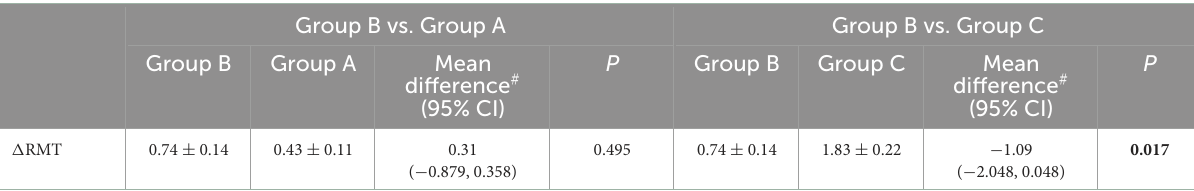
TABLE 9 Comparison of 1 RMT between the soft machine glove group and the conventional therapy and repetitive transcranial magnetic stimulation